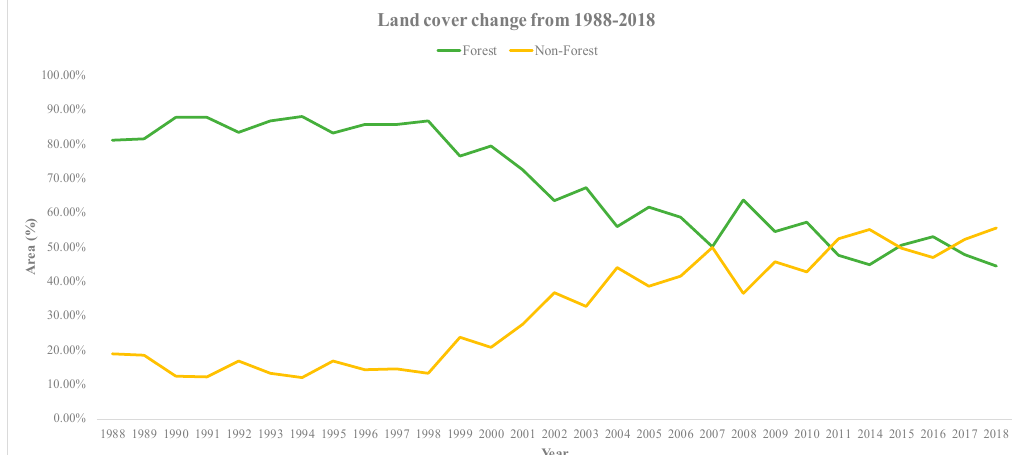
Figure 5. Land cover change in Siem Reap upstream.